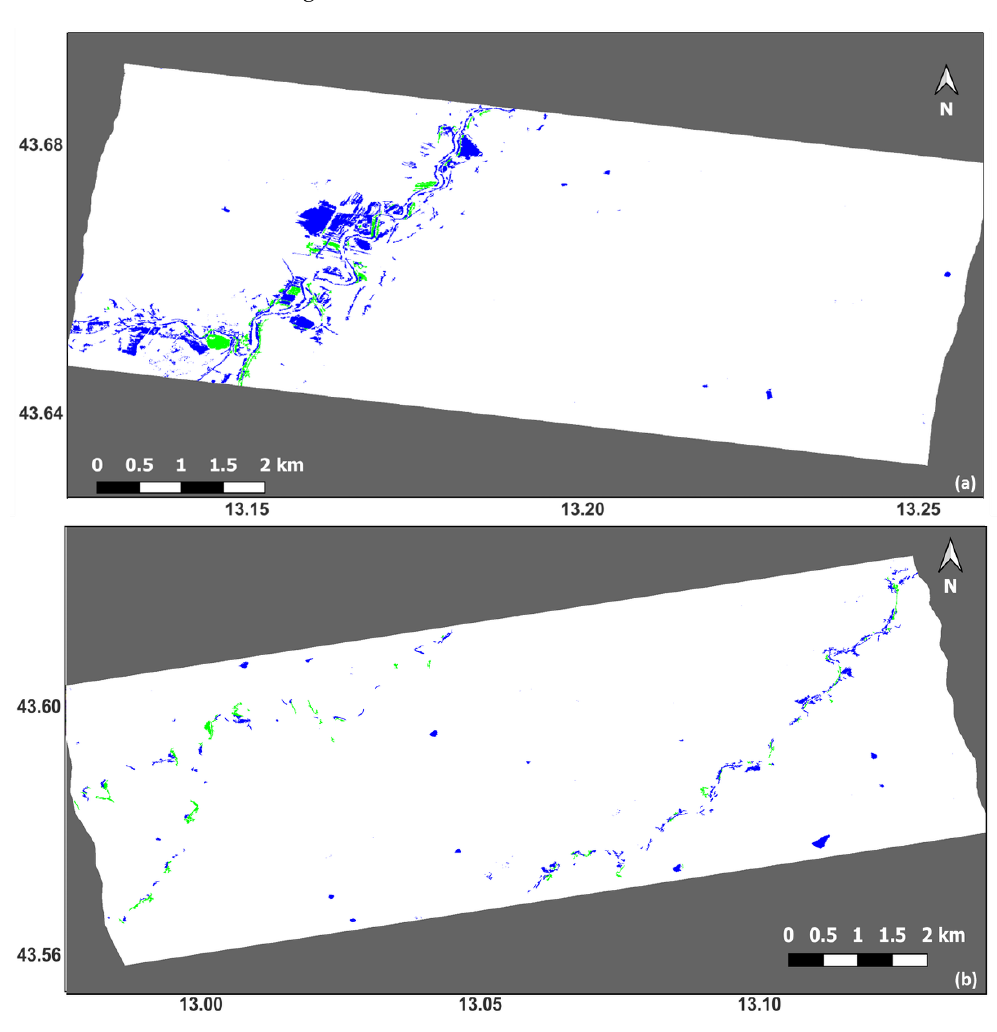
Figure 8. Maps of flooded areas generated using the CSG acquisition of 17 September 2022 ( a , Brugnetto area) and 18 September 2022 ( b , Ostra Vetere area). Blue: open water; green: flooded vegetation.